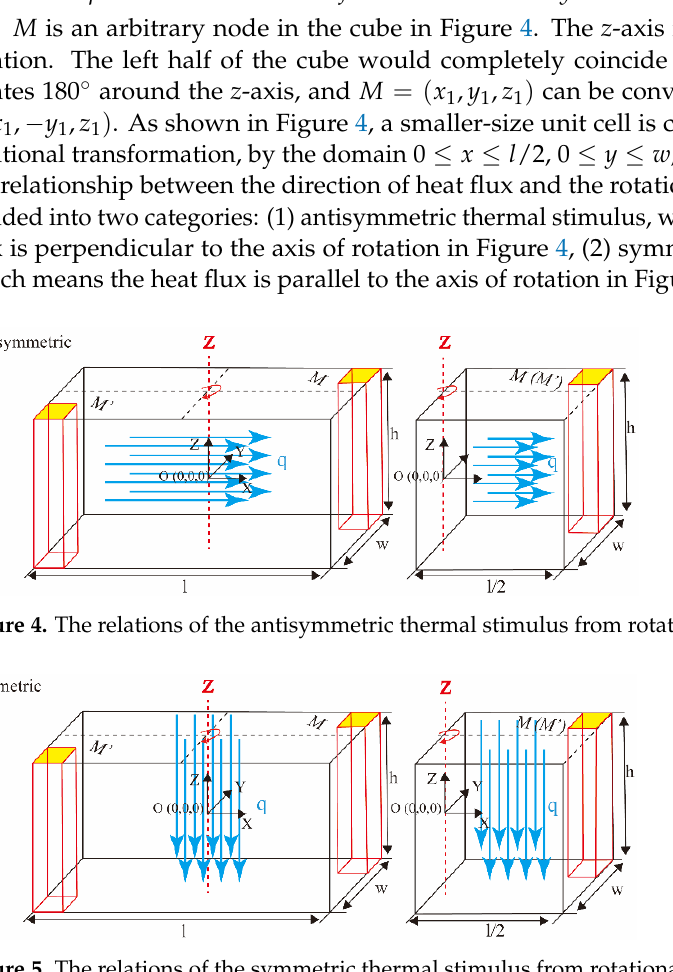
Figure 5. The relations of the symmetric thermal stimulus from rotational transformation.